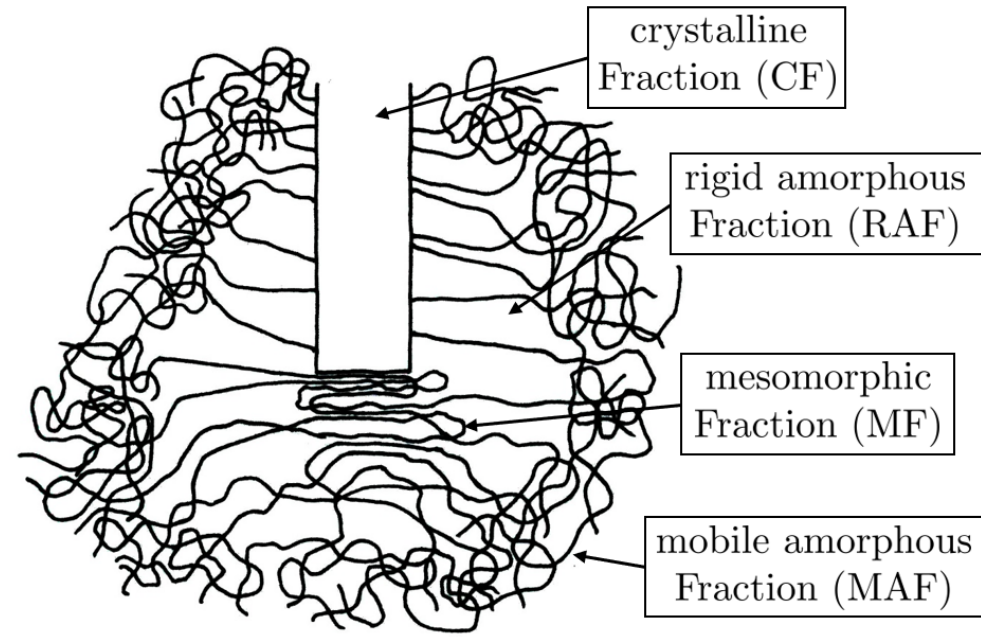
Figure 2. Schematic representation of the lateral growth of a crystallite to the lamella according to the four phase model, based on the model of Strobl